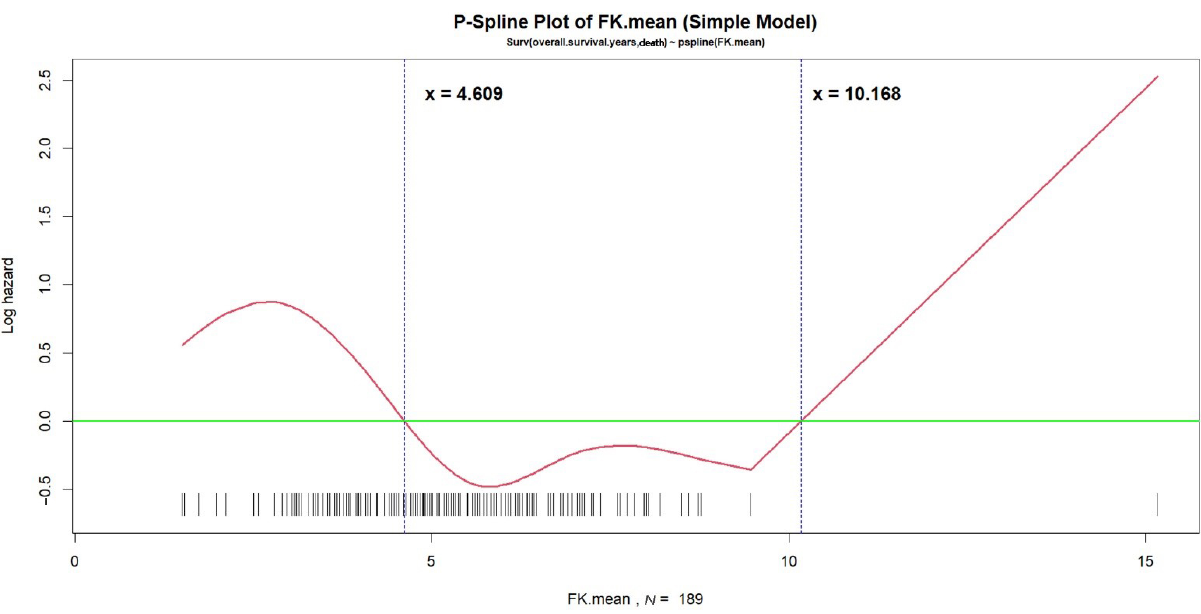
Figure 3. The p-spline plot for the nonlinear effect of the long-term tacrolimus blood trough levels on time to death. The tacrolimus blood trough level is shown on the X -axis, and the log( λ ), where λ is the hazard rate of time to death five years after liver transplantation, is shown on the Y -axis. In this p-spline plot, the intersection between the horizontal green line ( Y = 0) and the red curve yields the estimated optimal cut-off values for long-term tacrolimus blood trough levels at which the values of log( λ ) will not change (4.609 ng/mL and 10.168 ng/mL). When the level is ≤ 4.609 ng/mL or >10.168 ng/mL, the value of log( λ ) increases, indicating an increasing λ . When the level is >4.609 ng/mL and ≤ 10.168 ng/mL, the value of log( λ ) decreases, indicating a decreasing λ . The vertical bars above the X -axis represent the patients’ actual mean tacrolimus blood trough levels obtained at the three follow-up visits during the fifth year after